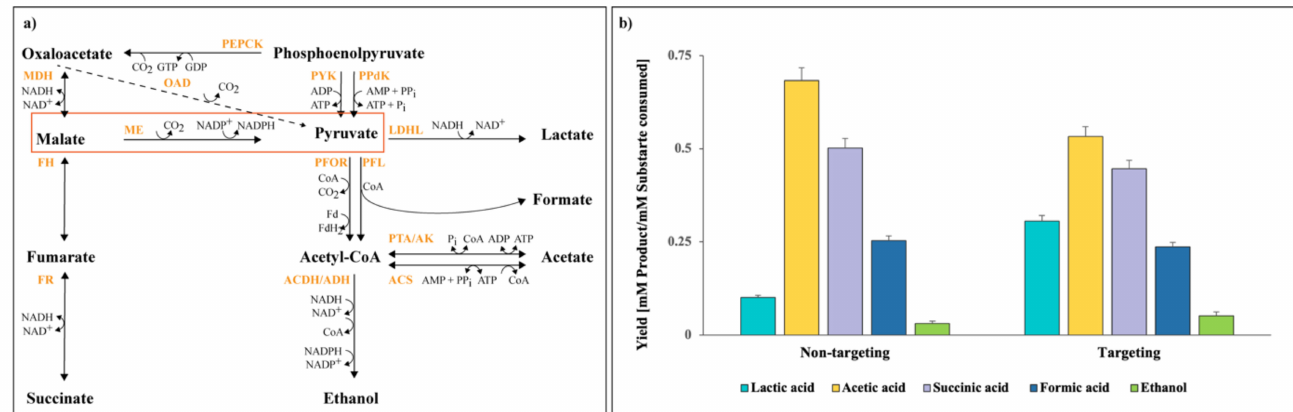
Figure 5. Impact of CRISPRi downregulation on the fermentation profile. ( a ) Illustration of P. thermo- succinogenes DSM 5809 metabolic pathways for conversion of phosphoenolpyruvate to major organic acids production, adapted from Koendjbiharie et al. [22]. ACDH—acetaldehyde